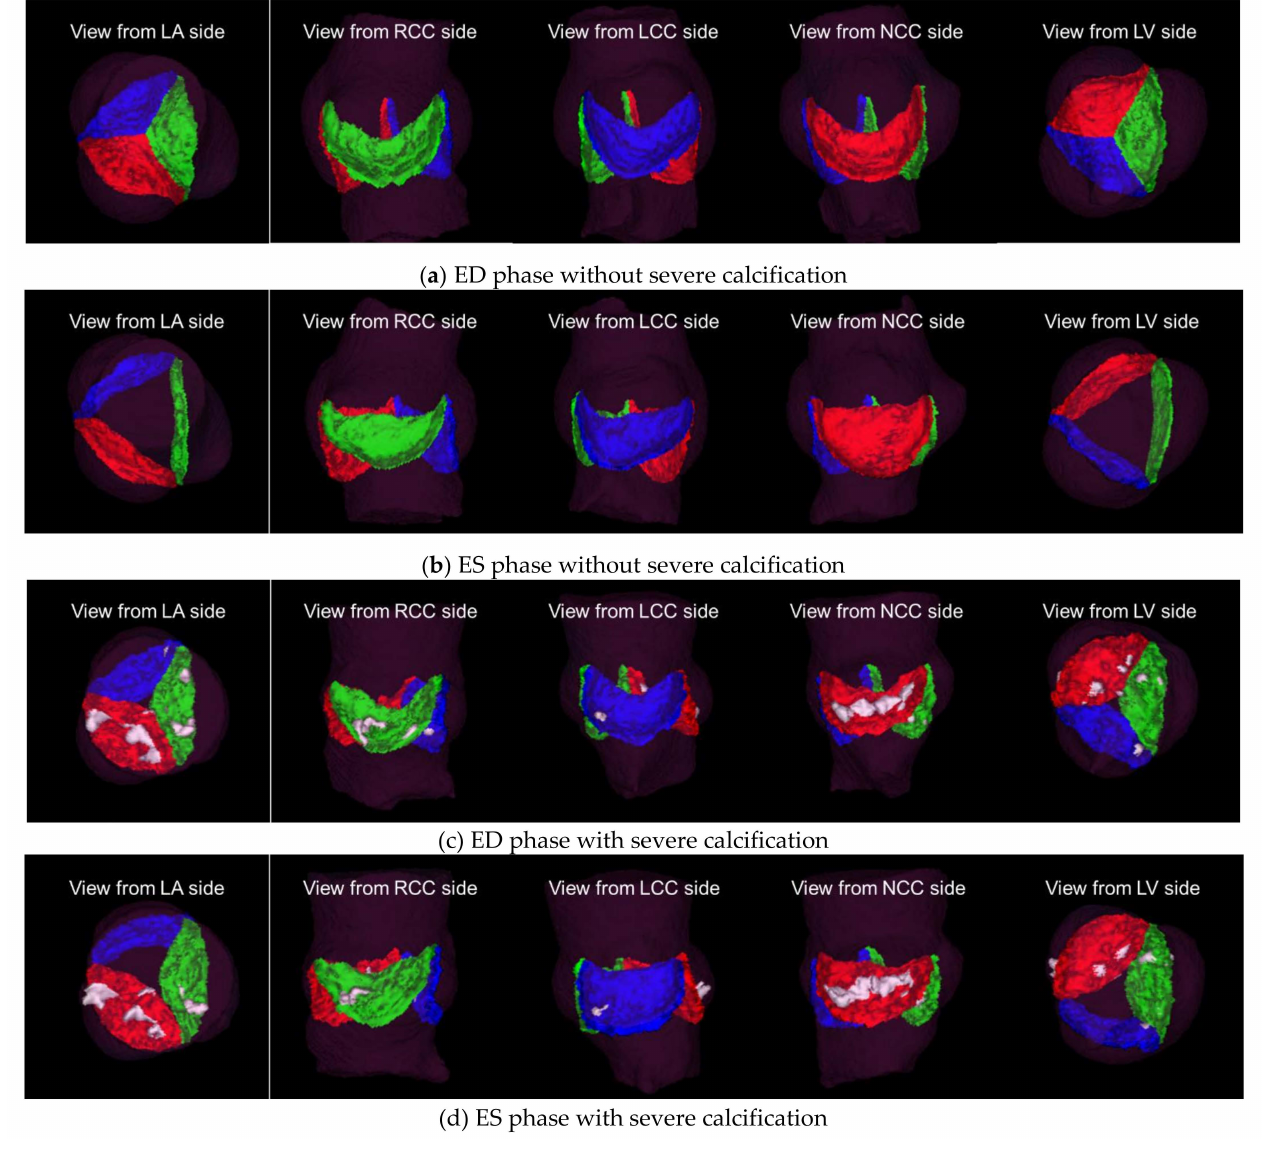
Figure 6. Visualization from five directions of VR images of segmentation results for two of the same cases as Figure 4: ( a , b ) a case without calcification; ( c , d ) a case with severe calcification. Translucent purple: aortic root labels, Green: RCC labels, Blue: LCC labels, Red: NCC labels and White: